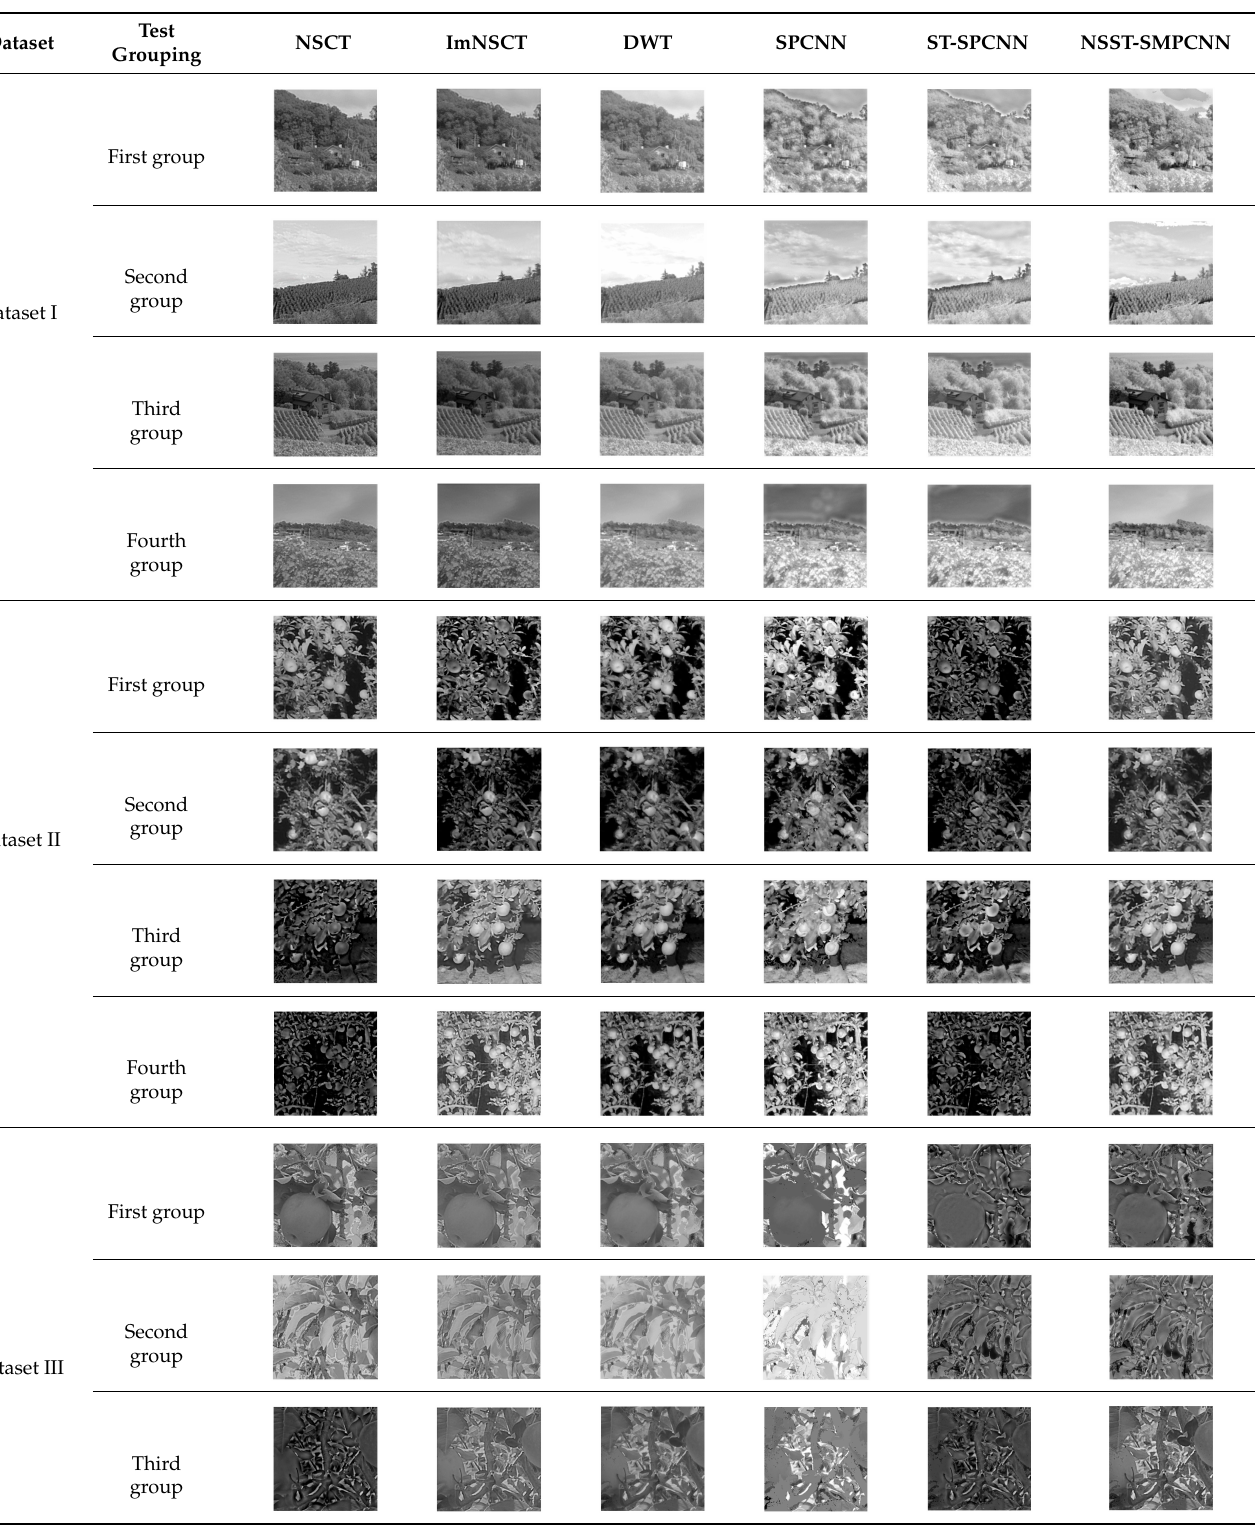
Table 4. Fusion effect of four